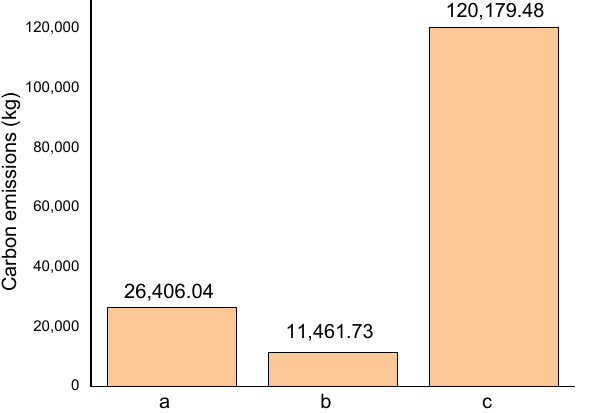
Figure 1. Comparison of carbon emissions of each part in the logistics and transportation stage.